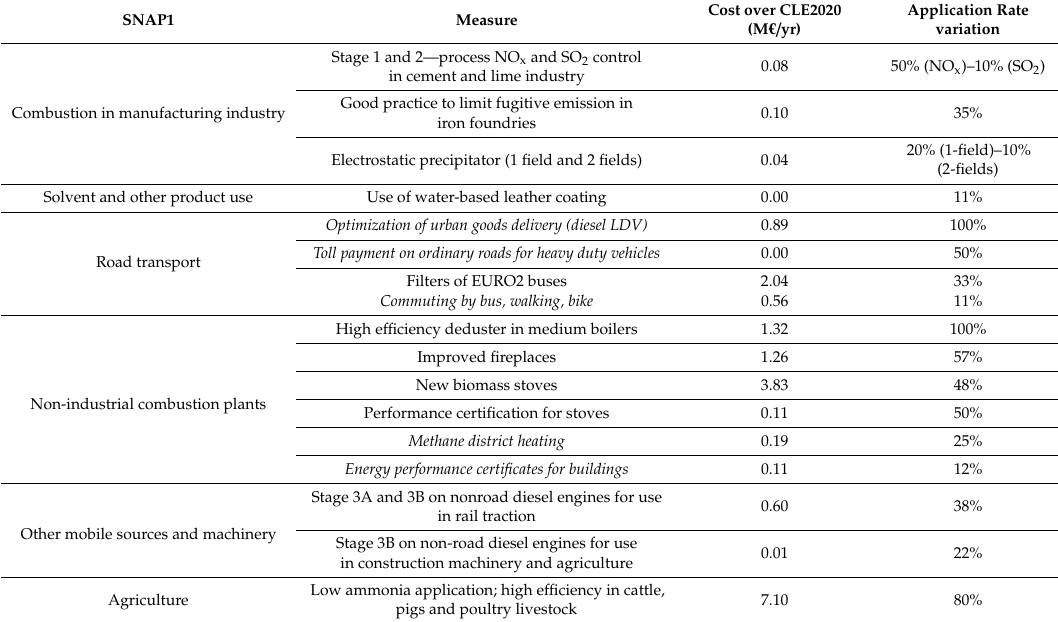
Table 4. Main measures, both end-of-pipe and energy measures (in italics), selected through the cost-e ff ectiveness optimization approach.